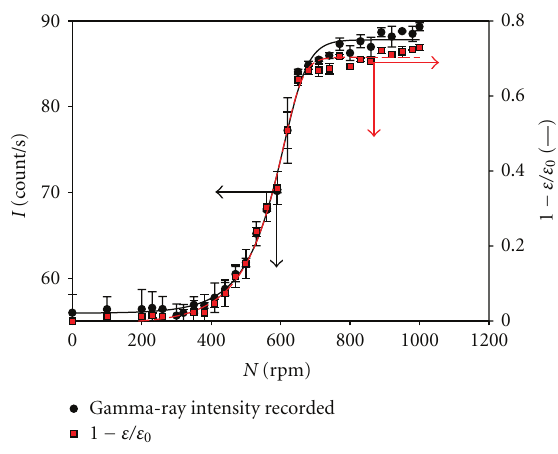
Figure 2: Variation of recorded count rate and average solid hold-up by increasing impeller speed at the bottom of the vessel. Impeller: RT, X: 20%, d p : 277 μ m, C/T :